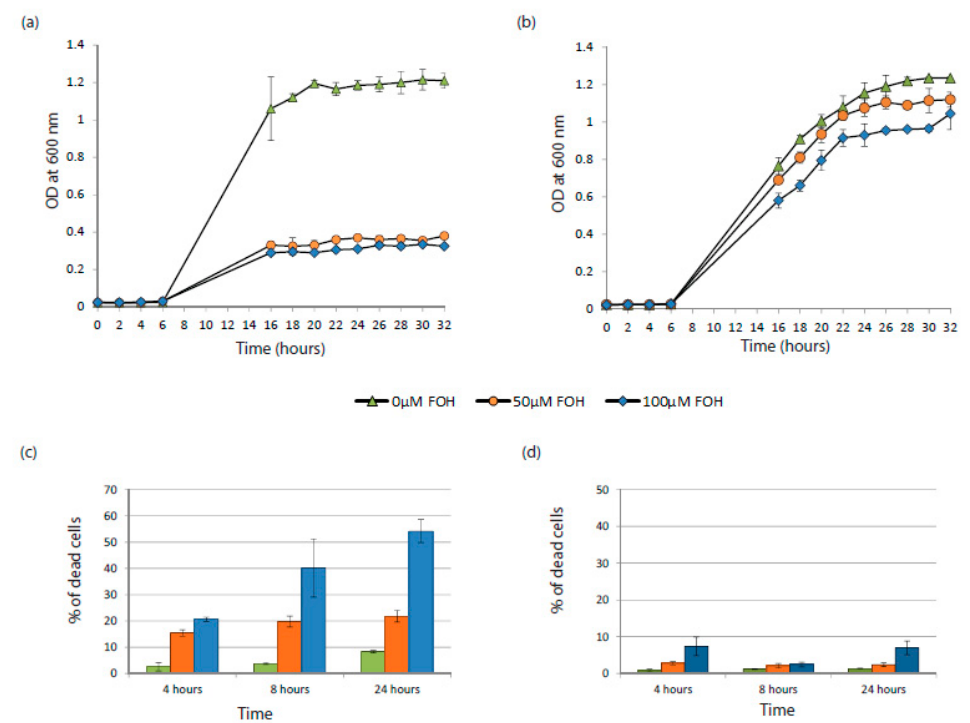
Figure 3. Longer ubiquinones increase the farnesol survival in S. cerevisiae —high aeration. Growth curves in yeast extract-peptone-dextrose (YPD) of ( a ) S. cerevisiae BY4741 and ( b ) S. cerevisiae △ coq1 + At2g 34630 in the absence of farnesol (triangles ) and in the presence of 50 µM (spheres ) or 100 µM (diamonds ) farnesol. Effect of farnesol on cell death for ( c ) S. cerevisiae BY4741 and ( d ) S . cerevisiae △ coq1 + At2g34630. Cultures were grown in the absence of farnesol (green solid fill) and in the presence of 50 µM (orange solid fill) or 100 µM farnesol (blue solid fill). For each time point, the bars are presented in sequence for 0, 50, and 100 µM farnesol. Cell viability was determined by methylene blue staining as the means ± standard error of triplicate experiments from YPD cultures after 4, 8, and 24 h growth.